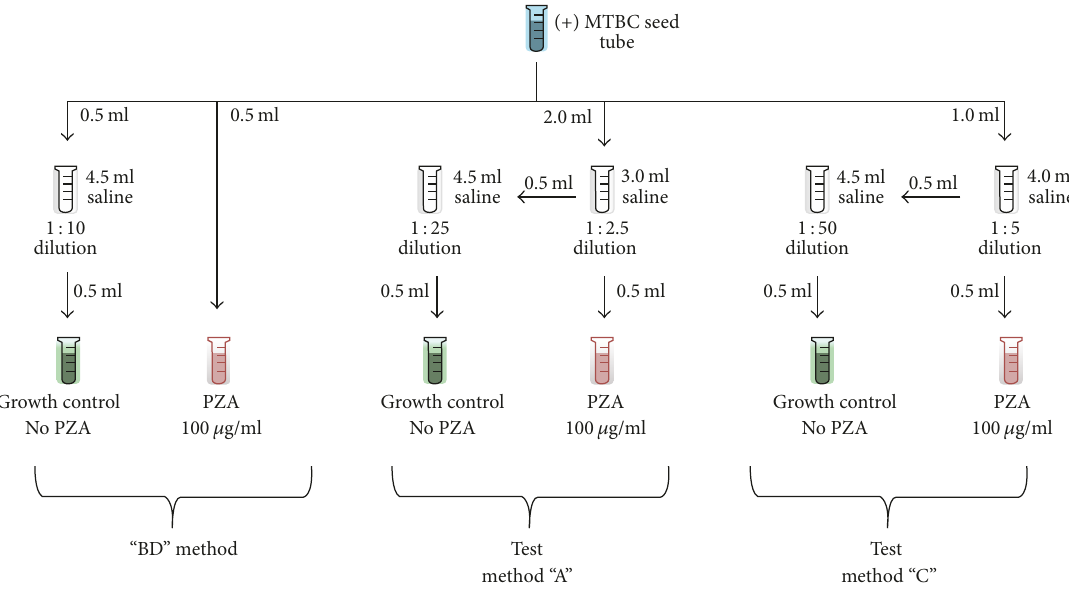
Figure 1: Procedural diagram of three MGIT PZA testing